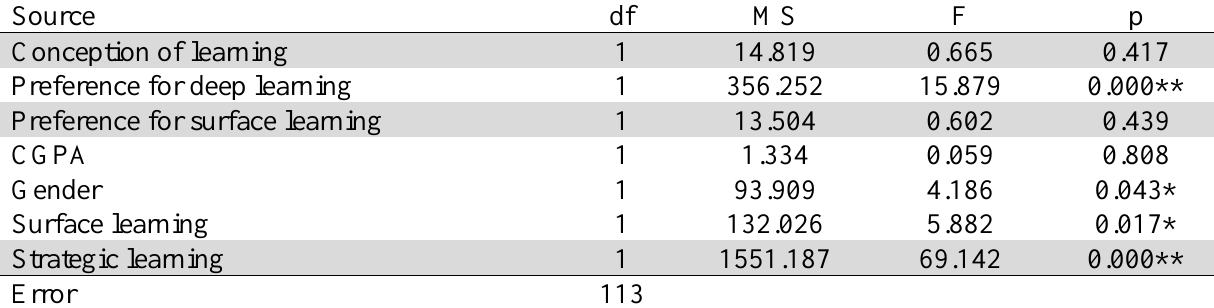
ANCOVA for deep